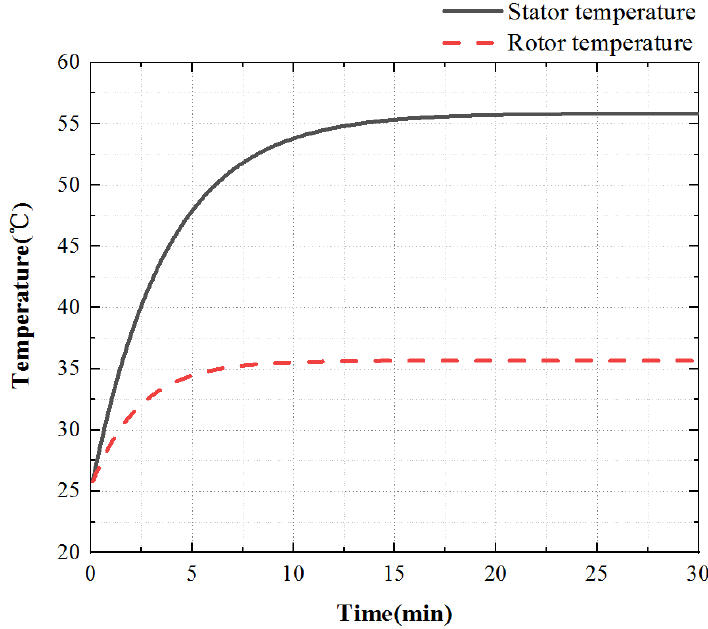
Figure 19. Temperature rise characteristic curve of the contact interface. In the process of friction heat generation, the rotor surface temperature is always lower than the stator surface temperature and the growth trend of the two is the same, and the rotor temperature reaches a stable state first. When t is 7 min, the rotor reaches the thermal stability state, and when t is 15 min, the stator reaches the thermal stability state.